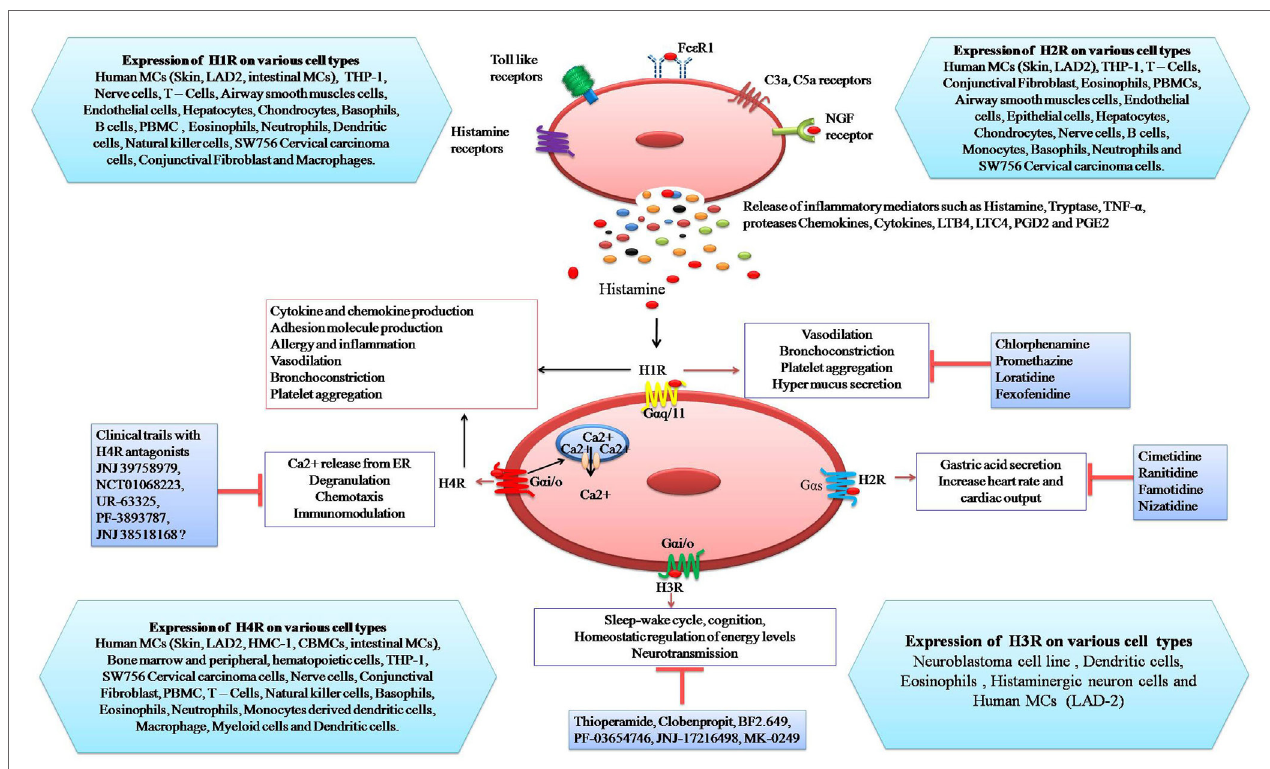
FiGURe 1 | Schematic representation of the expression of histamine receptors on mast cells and their potential response to histamine: binding of histamine to H1R induces vasodilatation, bronchoconstriction, platelet aggregation, and mucus hyper-secretion. Stimulation of H2R by histamine causes gastric acid secretion, increase heart rate, and cardiac output. Activation of H3R is involved in sleep-wake cycle, cognition, homeostatic regulation of energy levels, and neurotransmission. H4R activation leads to Ca ++ release from endoplasmic reticulum, degranulation, chemotaxis, and immuno-modulation whereas inhibitors of histamine receptors (H1R–H4R) inhibit specific